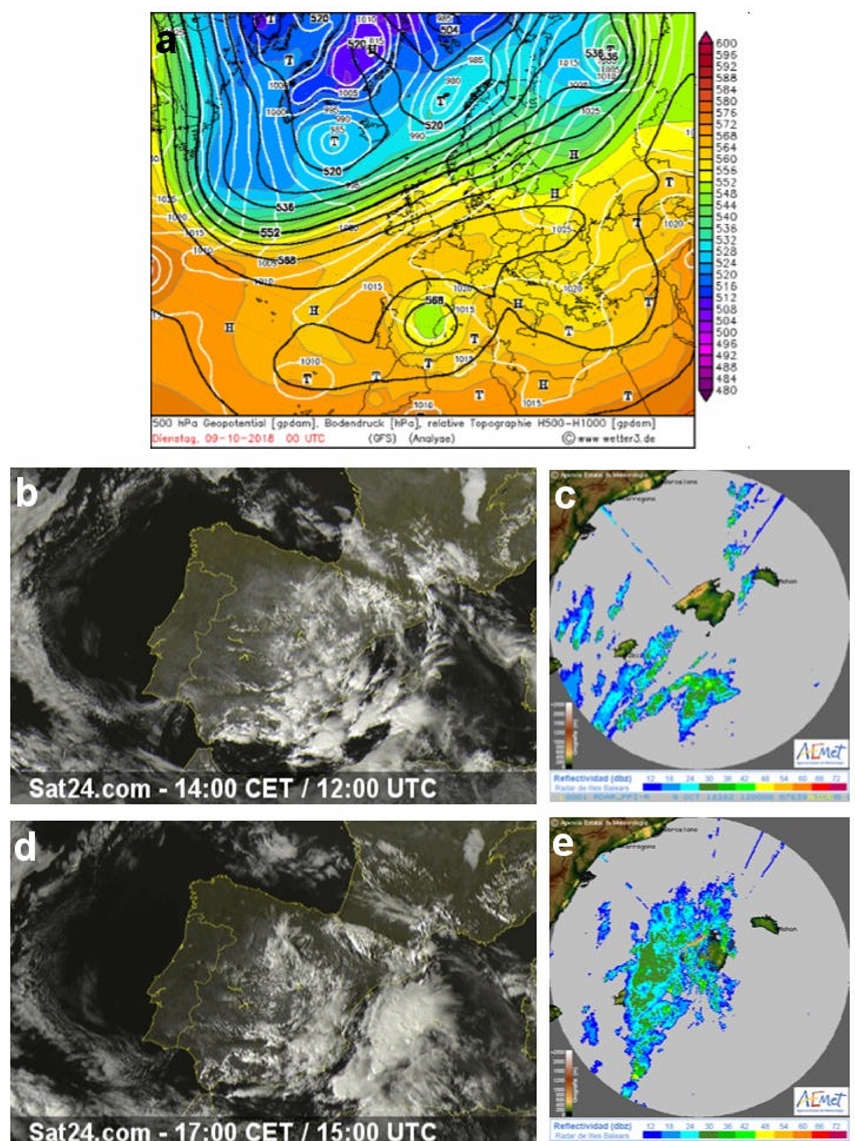
Figure 3. (a) Surface pressure and 500hPa height analyses at 12:00UTC on 9 October 2018 (source: http://wetter3.de (last access: 15 May 2020), i.e. at the beginning of the precipitation event. Satellite image at (b) 12:00UTC and (d) 15:00UTC (source: http://www. sat24.com, last access: 15 May 2020). EUMETSAT and radar images are shown for the same hours (c, e) (source: http://www.aemet.es,